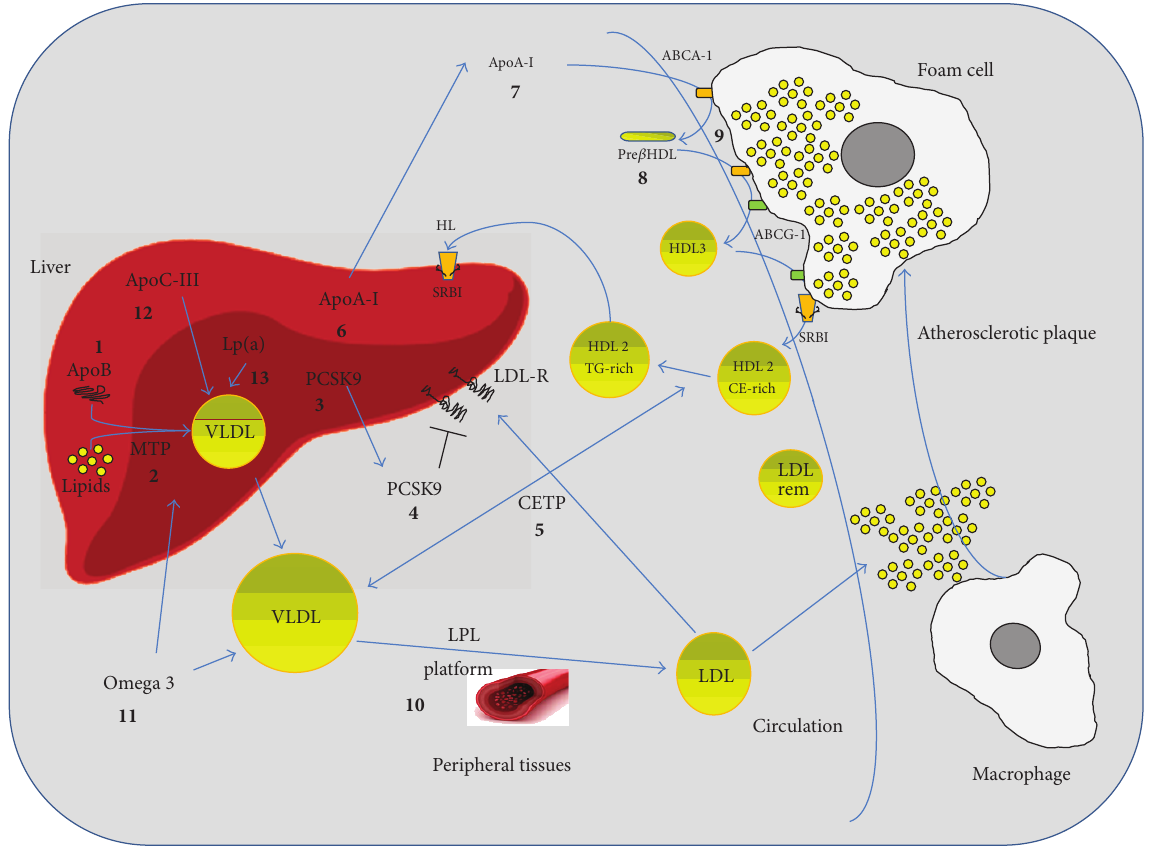
F 1: Emerging targets for dyslipidemia. e novel drugs that are under development for the treatment of dyslipidemia present several mechanisms of action. Emerging therapeutic agents for LDL lowering will: (a) interfere with lipoprotein synthesis in the liver by silencing apolipoprotein B (apoB) expression (1) or inhibiting microsomal triglyceride transfer protein (MTP) activity (2); (b) promote LDL-receptor activity by silencing (3) or blocking (4) proprotein convertase subtilisin/kexin type 9 (PCSK9). Emerging therapeutic agents affecting HDL will: (c) increase HDL-C plasma levels by blocking cholesteryl ester transfer protein (CETP) (5), or inducing apolipoprotein A-I (apoA- I) expression (6), (d) improve HDL activity by mimicking apoA-I (7) or nascent HDL (8) or increase the expression of receptors favoring cholesterol efflux from cells (9). Emerging therapeutic agents for triglycerides lowering will improve the catabolism of triglycerides and the handling fatty acids by peripheral organs (10), by new formulation of omega 3 fatty acids (11) and by inhibiting the expression of apolipoprotein C-III in the liver (12). Speci�c silencing of apolipoprotein (a) is also under investigation